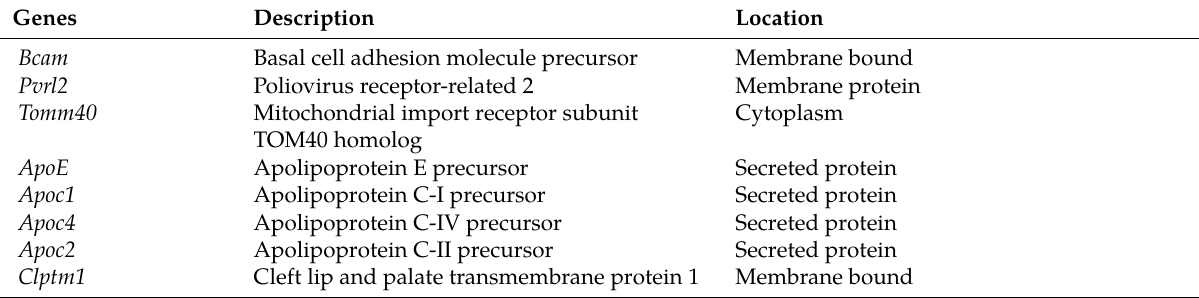
Table 1: Description of the genes used in the study within the vicinity of ApoE . Genes Description